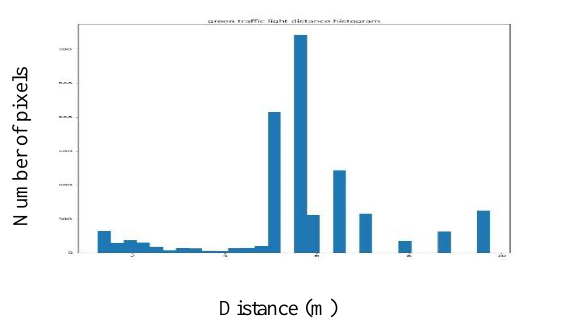
Fig. 5. Histogram of pixels inside the traffic light